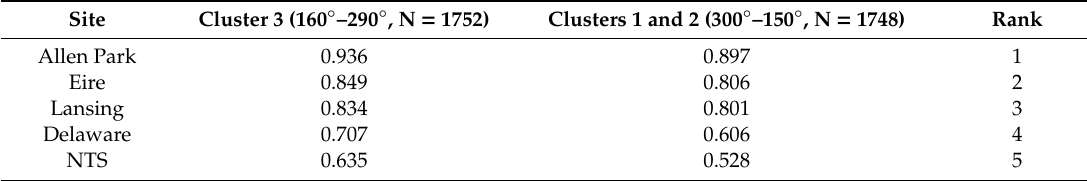
Table 6. Pearson correlation coe ffi cients between smog season 8 h max O 3 at Windsor and each of the five US sites by cluster (see Table 3). All correlations are significant at p < 0.05.